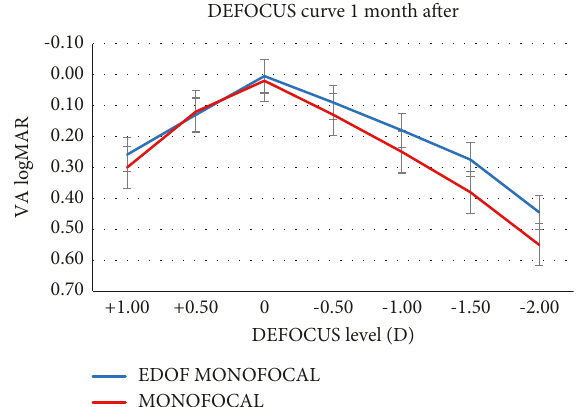
Figure 1: The defocus curve obtained monocularly with uncor- rection (EDOF: extended depth of focus; logMAR: logarithm of the minimum angle of resolution; VA: visual acuity).